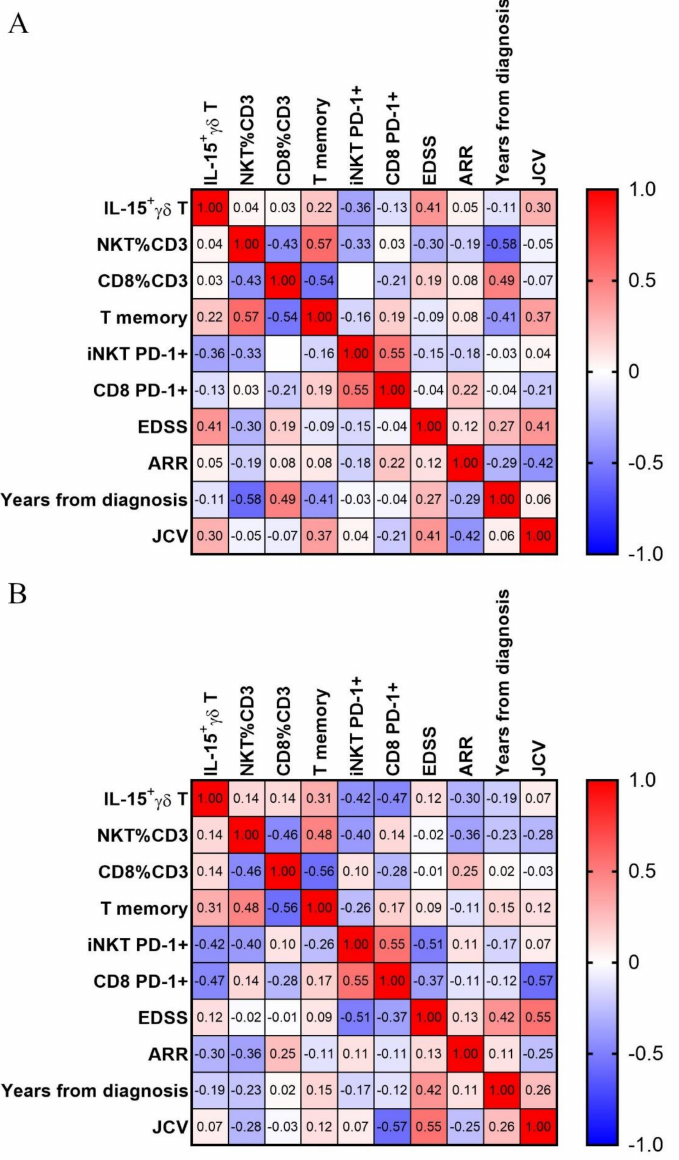
Figure 5. Correlation matrix. Correlations were calculated with Spearman test, and ρ values for each correlation are presented in respective squares. Panel ( A ) shows all MS patients, panel ( B ) only those in